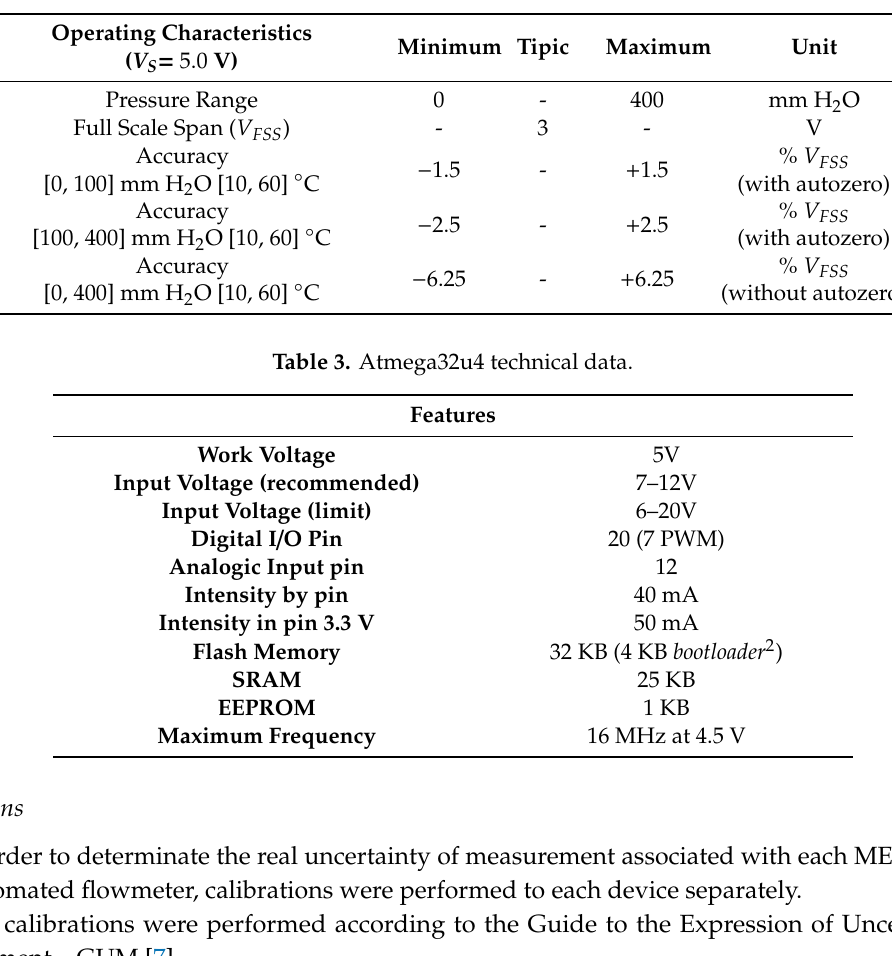
Table 2. MPXV5004DP technical data.